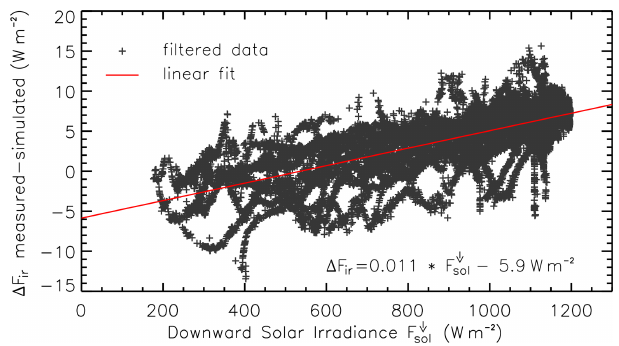
Figure 9. Difference between measured and simulated downward ↓ thermal–infrared irradiance (cid:49)F for 12 EUREC 4 A flights filtered ir for cloud-free conditions and flight altitudes above 10km. The dif- ferences are plotted and fitted as a function of the measured down- ↓ ward solar irradiance F sol